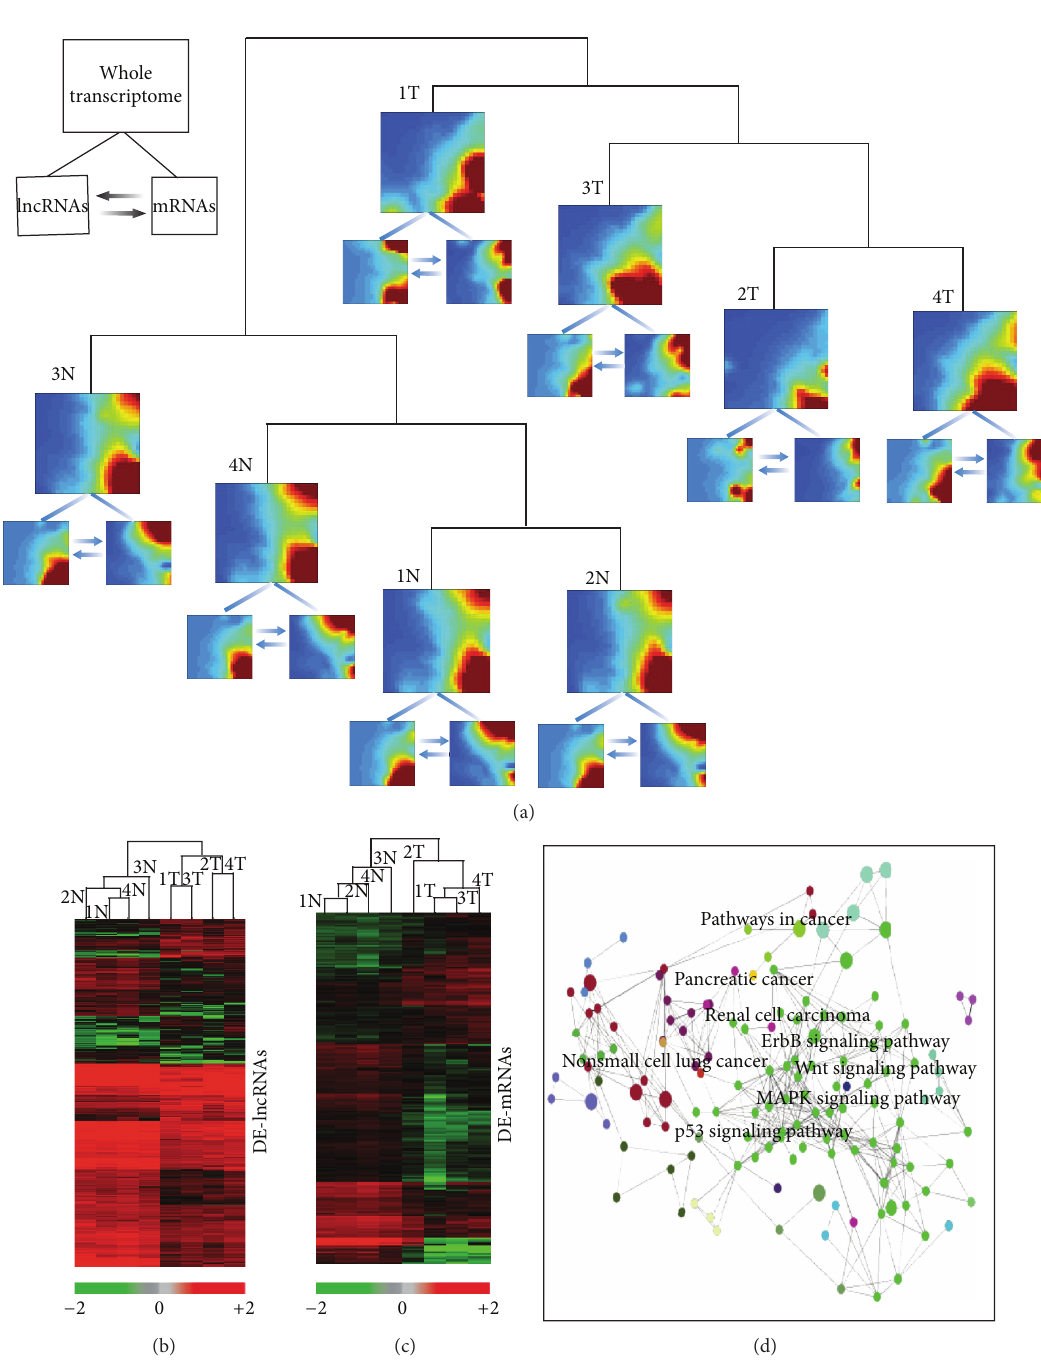
Figure 1: Transcriptomic landscape of esophageal squamous cell cancer (ESCC). (a) Whole transcriptome of tumor (T) and adjacent normal tissue (N) of four patients with ESCC were detected using a microarray with 7,419 long noncoding RNAs (lncRNAs) and 27,958 coding RNAs. Two main clusters (Ts and Ns) were generated using unsupervised clustering methods. Then, a self-organizing map (SOM) of either whole transcriptome (both lncRNAs and mRNAs) or lncRNAs or mRNA was produced from each sample (see legend in up-left corner of this figure, and the arrows are meant to indicate the potential interaction), using gene expression dynamic inspector (GEDI). Mosaic patterns are pseudocolored SOMs to show integrated biological entity in each sample. Red through blue color indicates high to low expression level. (b) and (c) Differentially expressed lncRNAs (DE-lncRNAs) and coding RNAs (DE-mRNAs) in ESCC. Hierarchical clustering analysis of 410 DE-lncRNAs (b) and 1219 DE-mRNAs (c) between ESCC tissue and adjacent normal tissue (fold change > or < 2-fold and 𝑃 < 0.05 ). Red and green colors indicate high and low expression, respectively. In the heatmap, columns represent samples, and rows represent each gene. The scale of expression level is shown on the horizontal bar. (d) KEGG functional analysis of DE-mRNA networks in ESCC. The DE-mRNA genes are involved in cancer-related signaling functions, and a detailed list of significant GO terms is shown in Figure S1 and its associated legend in Supplementary